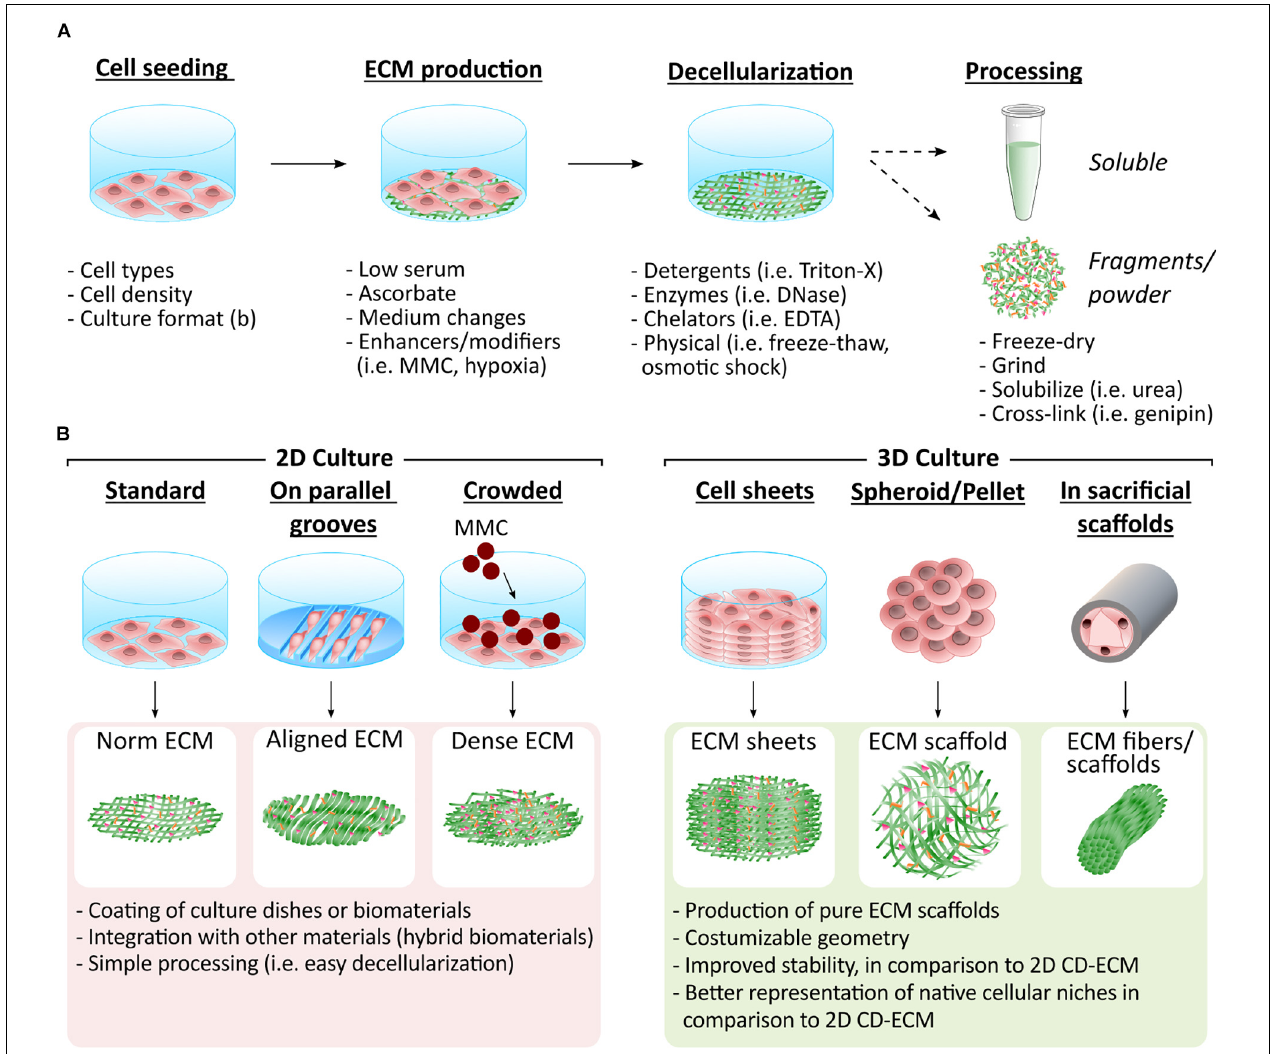
FIGURE 1 | Methodologies to generate CD-ECM in different formats. (A) CD-ECMs are synthesized by different cell types (i.e., MSCs and fibroblasts). Culture conditions are adjusted to facilitate ECM deposition by e.g., introducing MMC or hypoxia into cell culture. The assembled ECM is then gently decellularized, while preserving the ECM’s integrity as much as possible. The resulting CD-ECM can be used in its original format or further processed. (B) The arrangement in which the ECM producing cells are cultured determines the format of the CD-ECM material. Which type of presentation is most advantageous depends on the desired application. Easiest decellularization can be achieved in 2D cultures. The resulting CD-ECM is suitable for coating of culture dishes and biomaterial surfaces or can be further processed and integrated with other biomaterials, such as hydrogels. Integration of CD-ECM with other materials provides the opportunity to combine the bioactivity of the ECM with desired geometries and mechanical properties. CD-ECM assembled in 3D recapitulates native cellular niches more closely. It can thus be utilized to engineer improved tissue models and ECM 3D scaffolds with desired geometries. Various techniques exist that enable the construction of 3D scaffolds based on